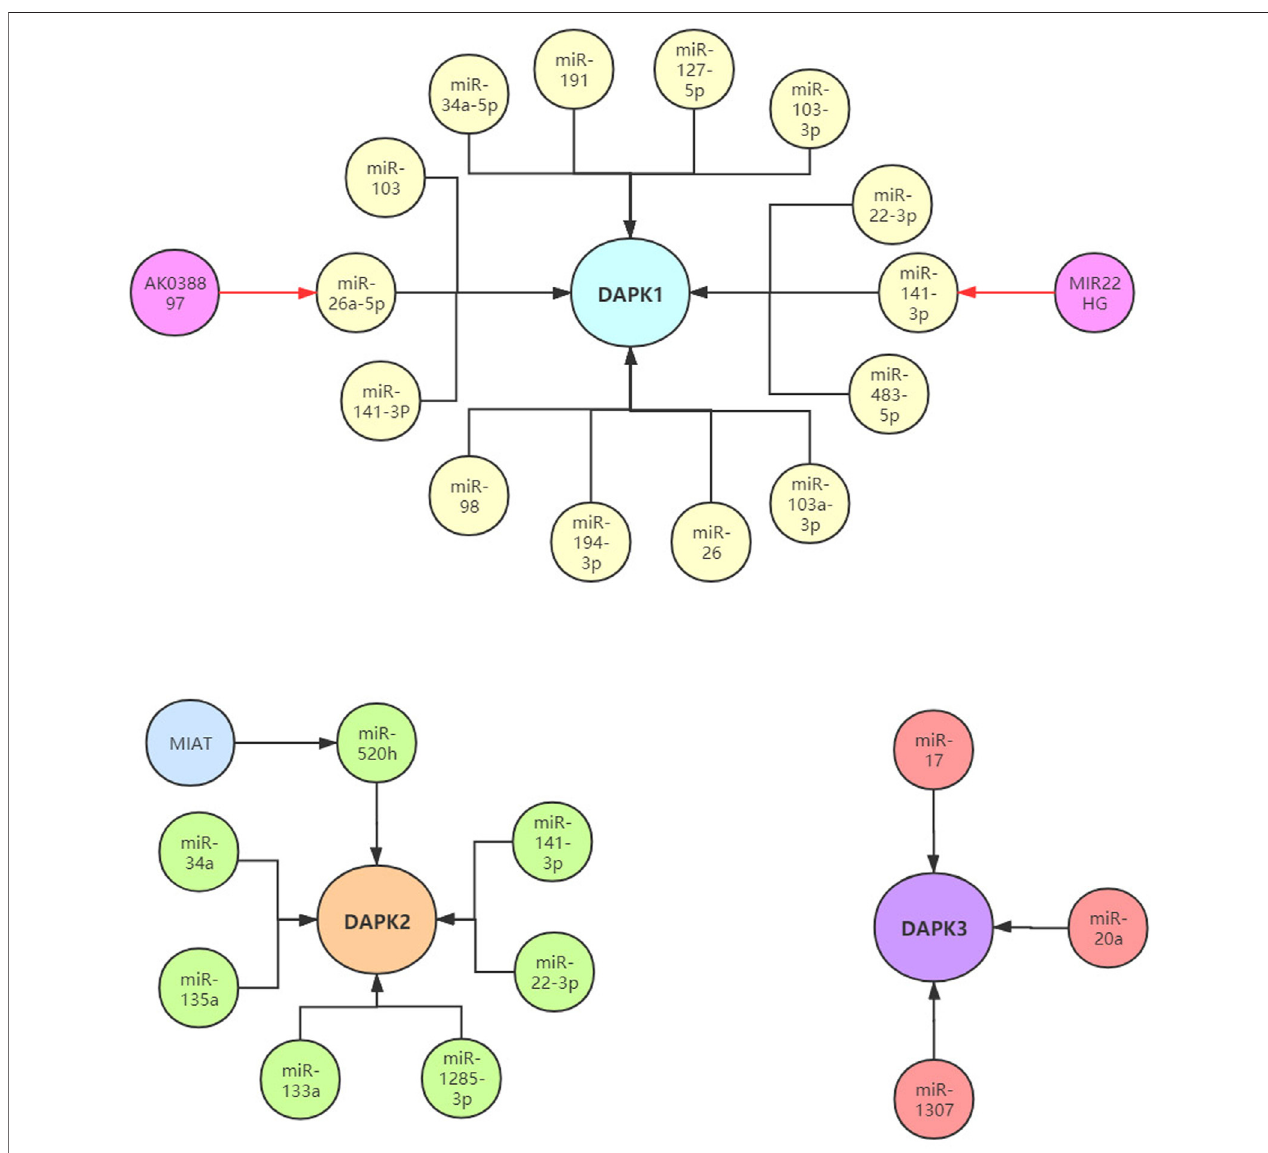
FIGURE 3 | The reported non-coding RNAs in the regulation of